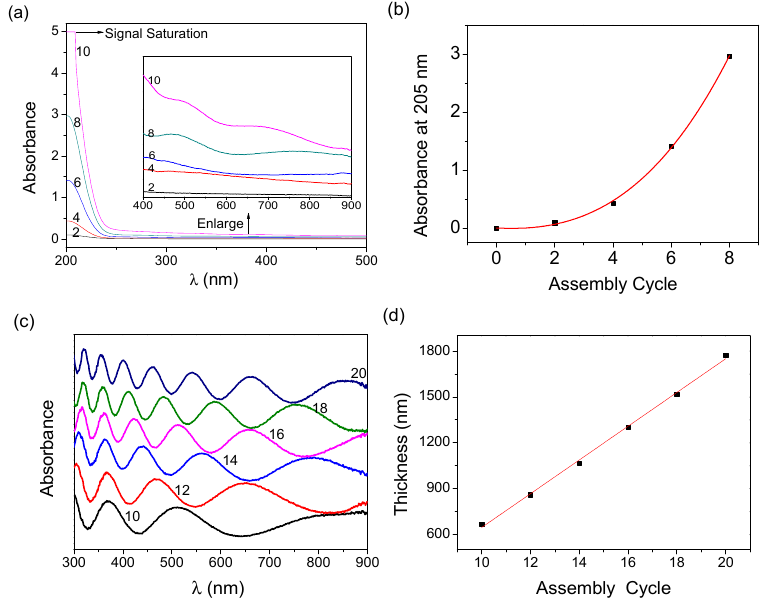
Figure 2. UV-visible spectroscopy was applied to monitor the PEOX/PAA film growth: ( a ) UV-vis spectra of the film as the number of assembling cycle increased from 2 to 10, spectroscopic range 200–500 nm; ( b ) The absorbance of the film at 205 nm as a function of assembly cycle; ( c ) UV-vis spectra of the film as the number of assembling cycle increased from 10 to 20, spectroscopic range 300–900 nm, for clearance spectra were intentionally overlaid; ( d ) The film thickness as a function of assembly cycle. (PEOX, M w 50,000, 1.0 mg/mL; PAA, M w 450,000, 1.0 mg/mL; pH 2.0; assembling time, 4 min; rinsing time, 1 min; and room temperature).